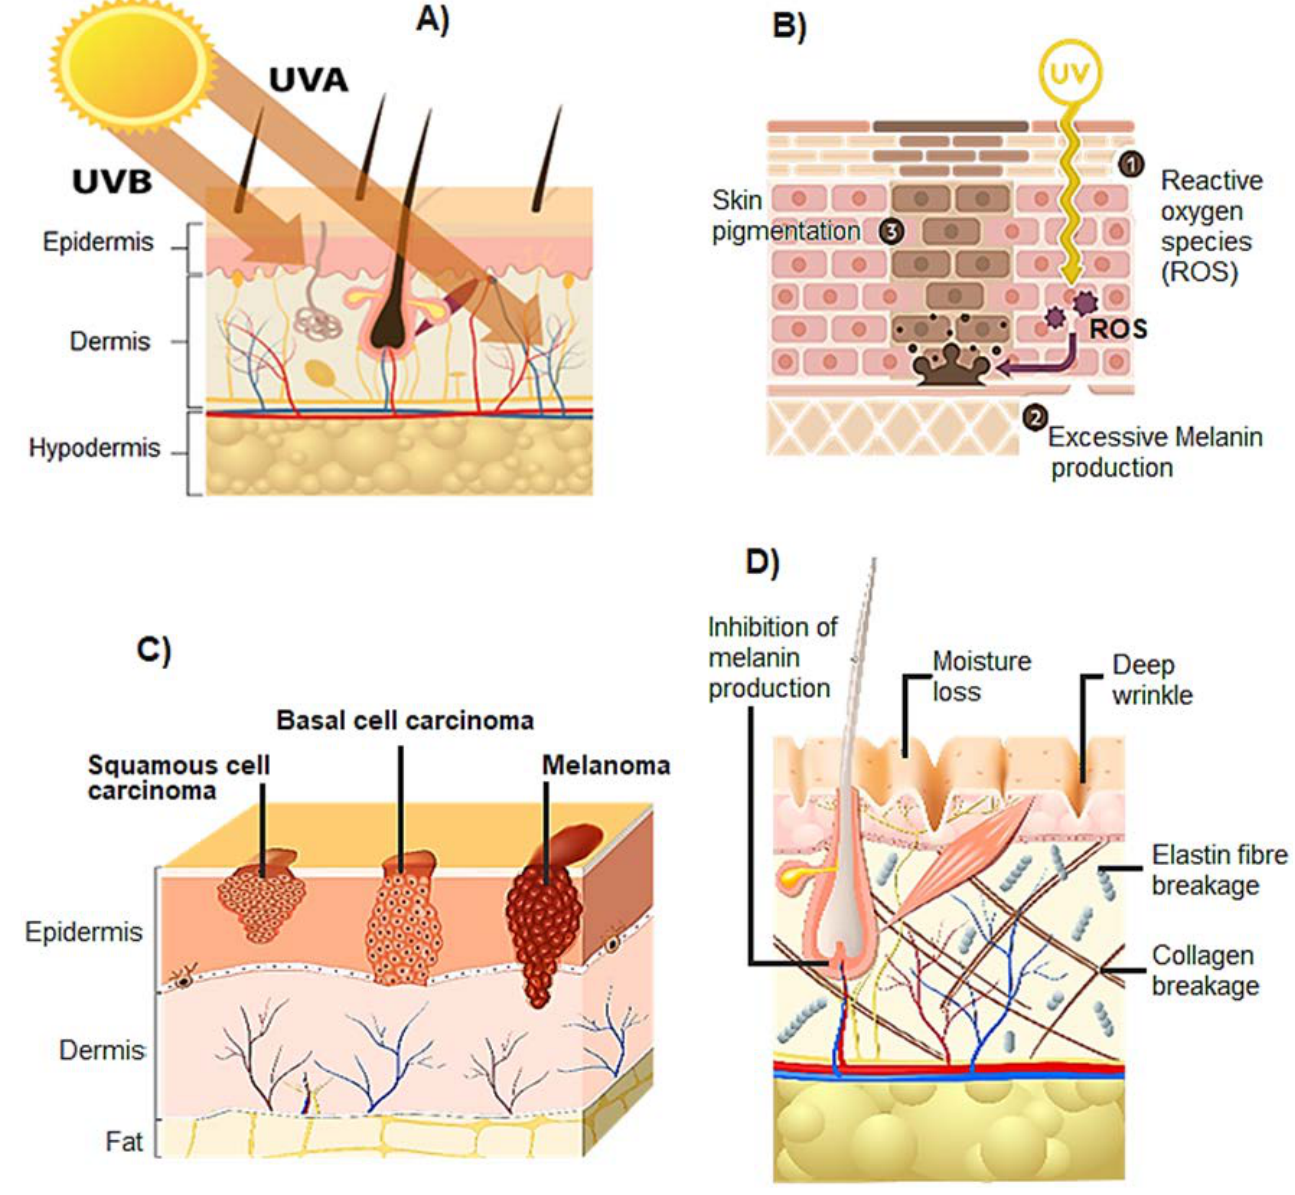
Figure 2. Skin permeation capacity of UVA and UVB radiation, and three main consequences of repeated exposure to UV radiation on the normal physiology of skin: ( A ) UVA light penetrates the dermis, while UVB radiation is absorbed by the epidermis; ( B ) hyperpigmentation; ( C ) carcinogenesis; and ( D ) aging.